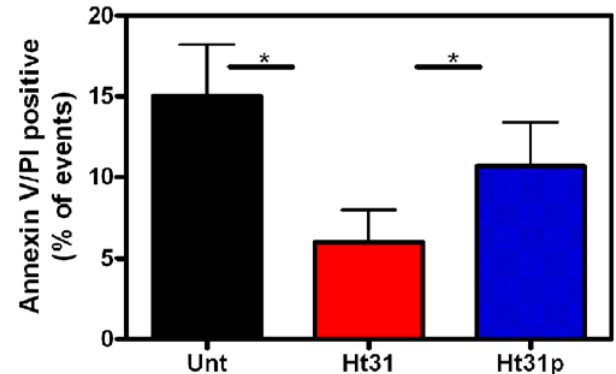
Figure 4. Ht31 blocks the ability of PKA activators to stimulate antigen presentation and T cell activation. Day 5 DC were incubated in the absence (black bar) or presence of 10 m M forskolin (green bars) or 1 m M PGE 2 (purple bars) and in the absence or presence of 100 m M Ht31 (red and red hatched bars) or 100 m M Ht31p (blue and blue hatched bars). CFP10 protein antigen (0.03 m g/ml) was added and after 1 hr incubation at 37 u C, 5% CO 2 , antigen specific CD4 + clonal T cells were added. IFN- c production was assayed by ELISPOT after 16 hr at 37 u C, 5% CO 2 . Six experiments were normalized and averaged. Error bars are S.E.M. Student TTEST reveals significance P , 0.05(*).